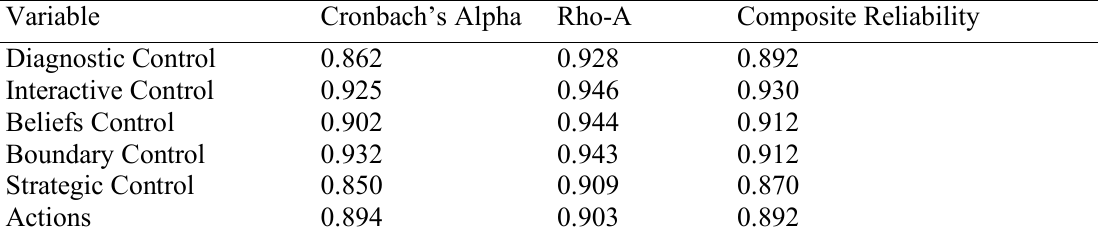
Table 2 . Reliability and Validity of